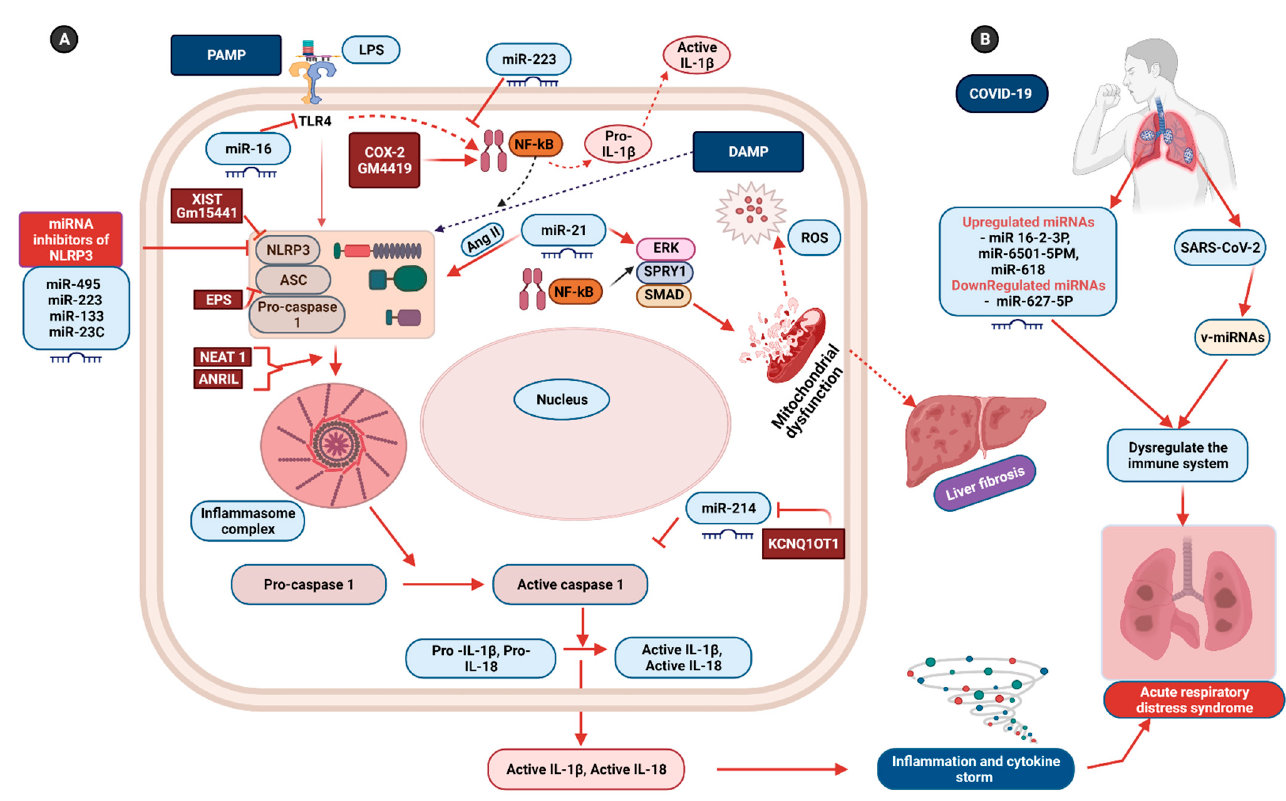
Figure 2. The mechanism of NLRP3 pathway activation and its regulation by ncRNAs. ( A ) The priming of NLRP3 occurs when TLR4 senses some PAMPs and activates the NF-kB pathway, which helps in the expression and release of pro-IL-1 β . Both PAMP and DAMP molecules result in the inflammasome activation and release of pro-inflammatory cytokines. Non-coding RNAs can regulate the expression of NLRP3 inflammasome at various stages. miR-16 blocks NLRP3 activation by specifically targeting TLR4 receptors. MiR-495 and miR-223 specifically target the NLRP3. MiR-214 binds caspase 1. The lncRNA EPS inhibits the expression of ASC protein. ncRNAs also positively regulate the activation of NLRP3 inflammasome. MiR-21 regulates NLRP3 expression via ERK/SPRY/SMAD pathways, and results in mitochondrial dysfunction and ROS generation, which trigger inflammasome activation. This process induces liver fibrosis. The lncRNA NEAT1 helps in the assembly of NLRP3 and downstream factors, such as caspase 1 and IL-1 β . KCNQ1OT1 binds miR-214, thus preventing its binding with caspase 1. The lncRNA COX-2 and GM4419 enhance NLRP3 expression by interacting with NF-kB. The lncRNA ANRIL regulates NLRP3 by the upregulation of the BRCC3 gene. The lnc Gm15441 and lnc XIST suppress the expression of NLRP3. ( B ) miRNAs in patients with COVID-19 and SARS-CoV-2-derived miRNAs dysregulate the immune system, resulting in ARDS. Ang II—angiotensin II; ANRIL—antisense RNA in the INK4 locus; ARDS—acute respiratory distress syndrome; ASC—apoptosis-associated speck-like protein containing a caspase activation and recruitment domain; COVID-19—coronavirus disease 2019; COX-2—Cyclooxygenase-2; DAMPs—damage-associated molecular patterns; EPS—epidermal growth factor receptor pathway substrate; ERK—extracellular regulated MAP kinase; IL-1 β —interleukin 1 beta; LPS—lipopolysaccharide; lncRNA—long non-coding RNA; miRNA—microRNA; NEAT 1— nuclear paraspeckle assembly transcript 1; NF-kB—nuclear factor kappa light chain stimulation of activated B cells; NLRP3—nucleotide-binding oligomerization domain, leucine-rich repeat, and pyrin domain-containing 3 protein; PAMPs— pathogen-associated molecular patterns; ROS—reactive oxygen specious, SARS-CoV-2—severe acute respiratory syndrome coronavirus 2; SMAD—mothers against DPP homolog 2; SPRY1—sprouty RTK signaling antagonist 1; TLR—Toll-like receptor; v-miRNAs—viral microRNAs; XIST—X-inactive specific transcript. The symbol “ ⊥ ” indicates inhibition; solid arrow indicates the direction of effect; dotted arrow indicates alternative